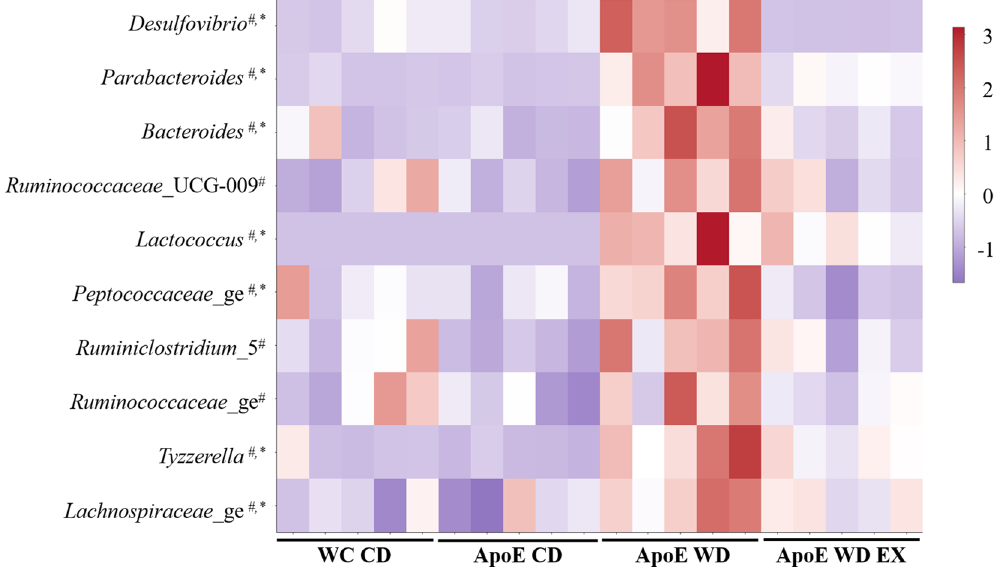
Figure 4. Effects of endurance exercise on gut microbiota at the genus level in ApoE knockout mice. Heatmap of integrated microbiota abundance among the WT CD, ApoE CD, ApoE WD, and ApoE HD EX groups. Significant differences were assessed using one-way ANOVA followed by a Duncan post hoc test. *Significant difference between ApoE WD and ApoE WD EX; # Significant differences among ApoE WD, ApoE CD, and WT